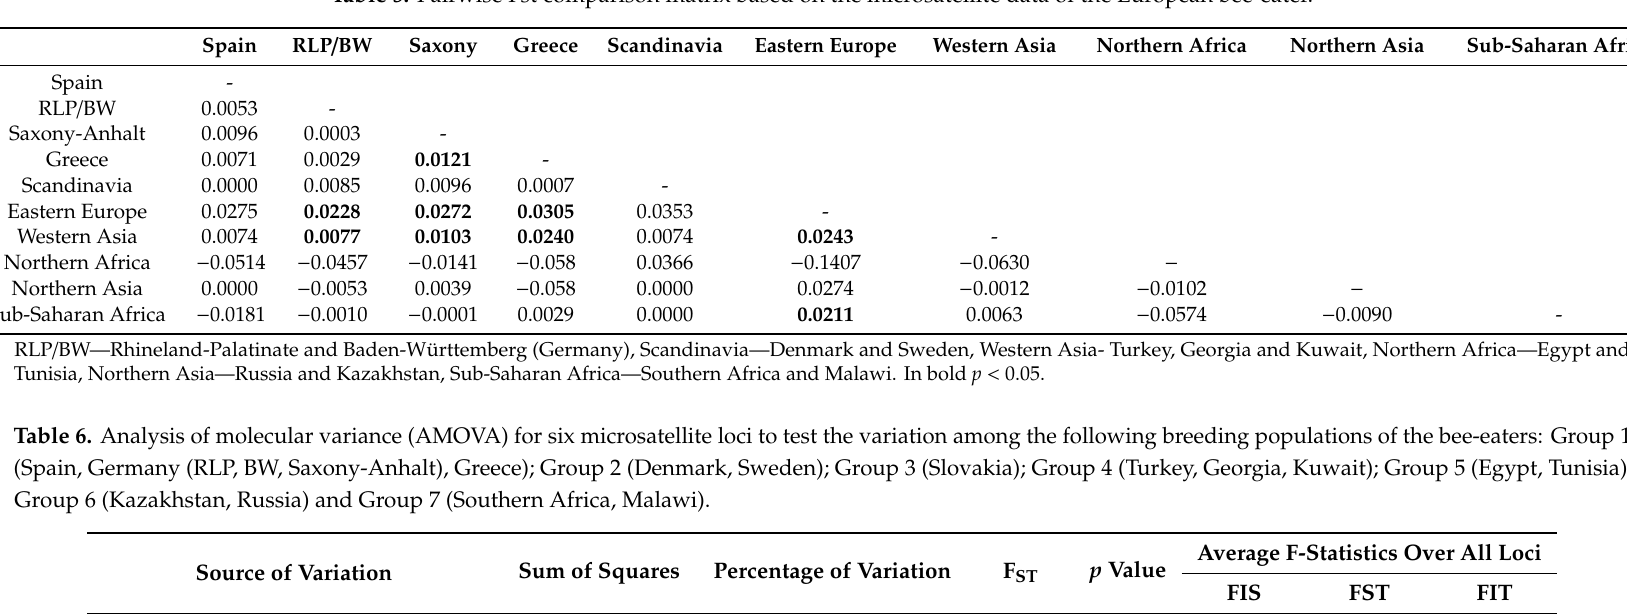
Table 5. Pairwise Fst comparison matrix based on the microsatellite data of the European bee-eater. Spain RLP / BW Saxony Greece